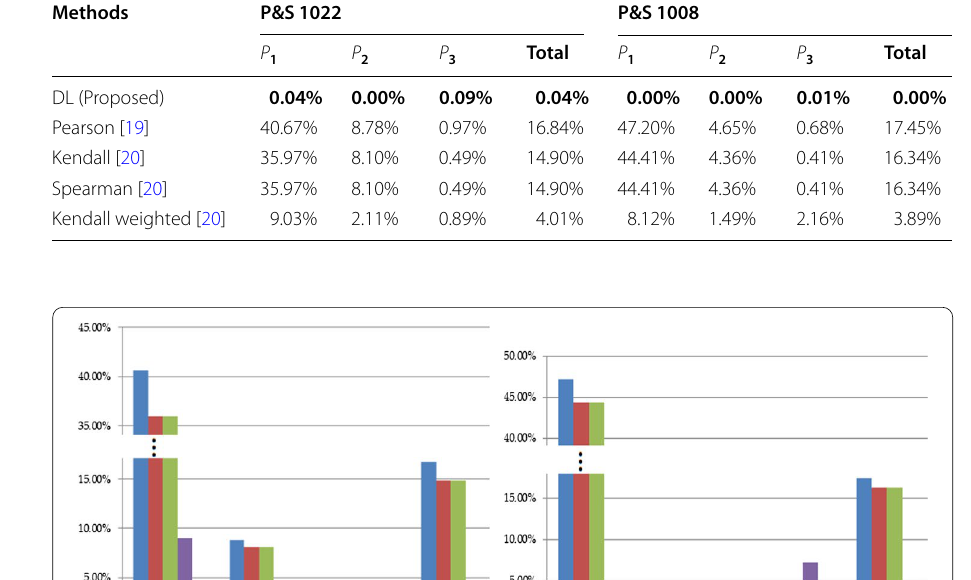
Table 1 Error probability of pattern recognition Methods